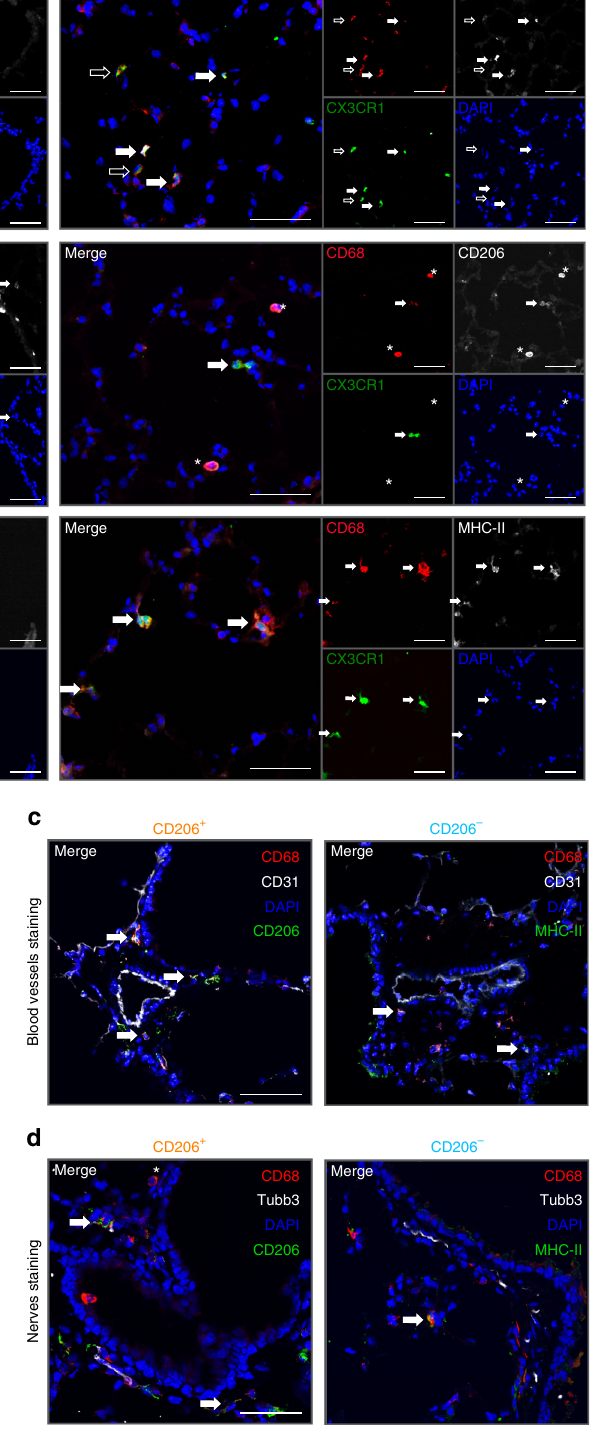
percentages of IL-10 + cells (Fig. 5c, d). Second, we found that the percentage of CD206 + IM expressing IL-10 was signi fi cantly higher than the one of CD206 − IM (Fig. 5c, d). Third, we showed that the percentage of IL10 + CD64 + CD16.2 + monocytes was signi fi cantly higher than the one of IL-10 + patrolling Ly-6C lo monocytes (Fig. 5c, d), pointing out another notable difference between CD64 + CD16.2 + and patrolling